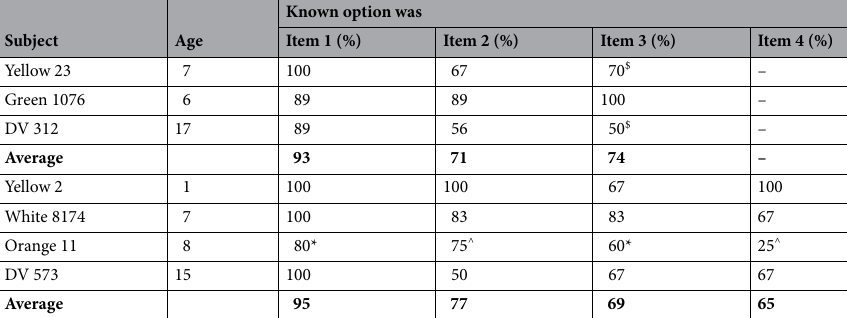
Table 3. Percentage of Choice Test trials during which a subject chose the known item when the choice was between a known (sequence items 1, 2, 3, or 4, as applicable) and an unknown item (sequence items 5, 6, or 4, as applicable), or between two unknown items. Individuals are listed in order of the number of items they were trained on; those that only completed up to TS3 were not presented with sequence item 4 as a known option. Percentages are based on nine trials for subjects Yellow 23, Green 1076 and DV 312, and on six trials for Yellow 2, White 8174 and DV 753. $ Based on ten trials. *Based on five trials. ^ Based on four trials.